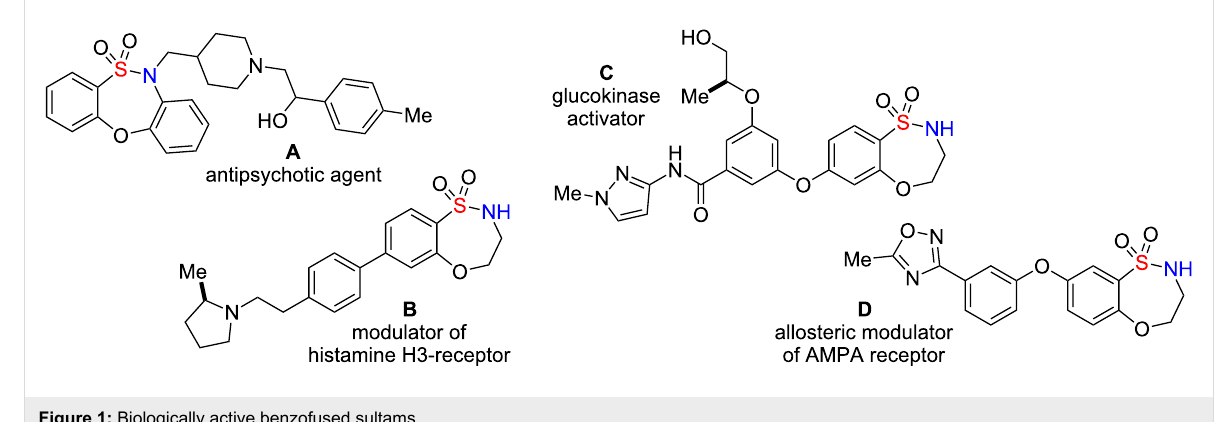
Figure 1: Biologically active benzofused sultams.